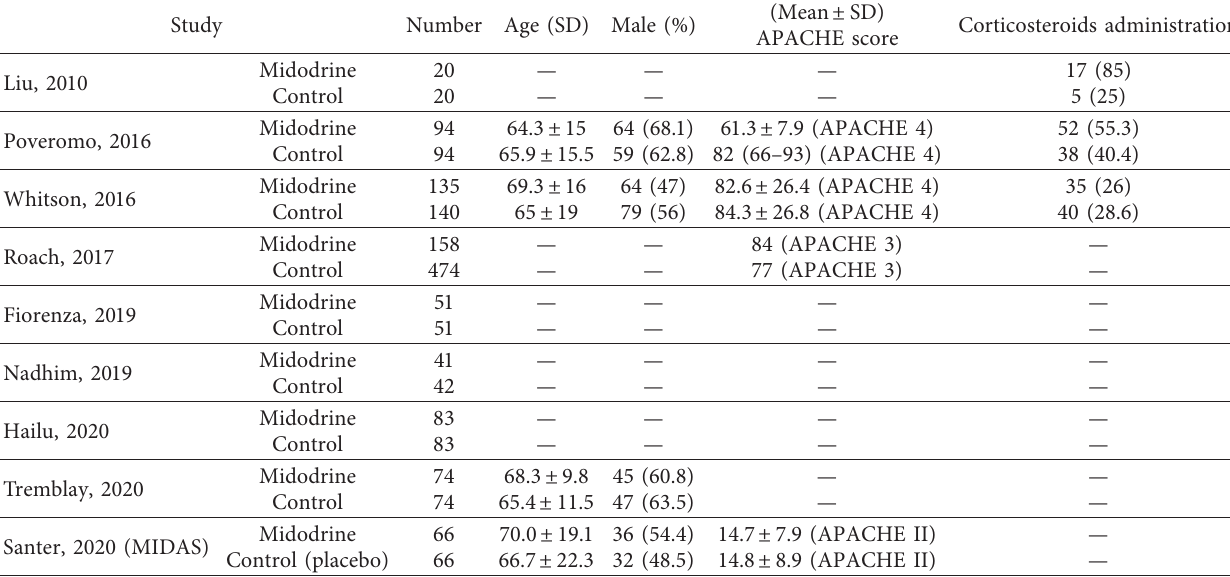
Table 2: Demographics of participants of the included